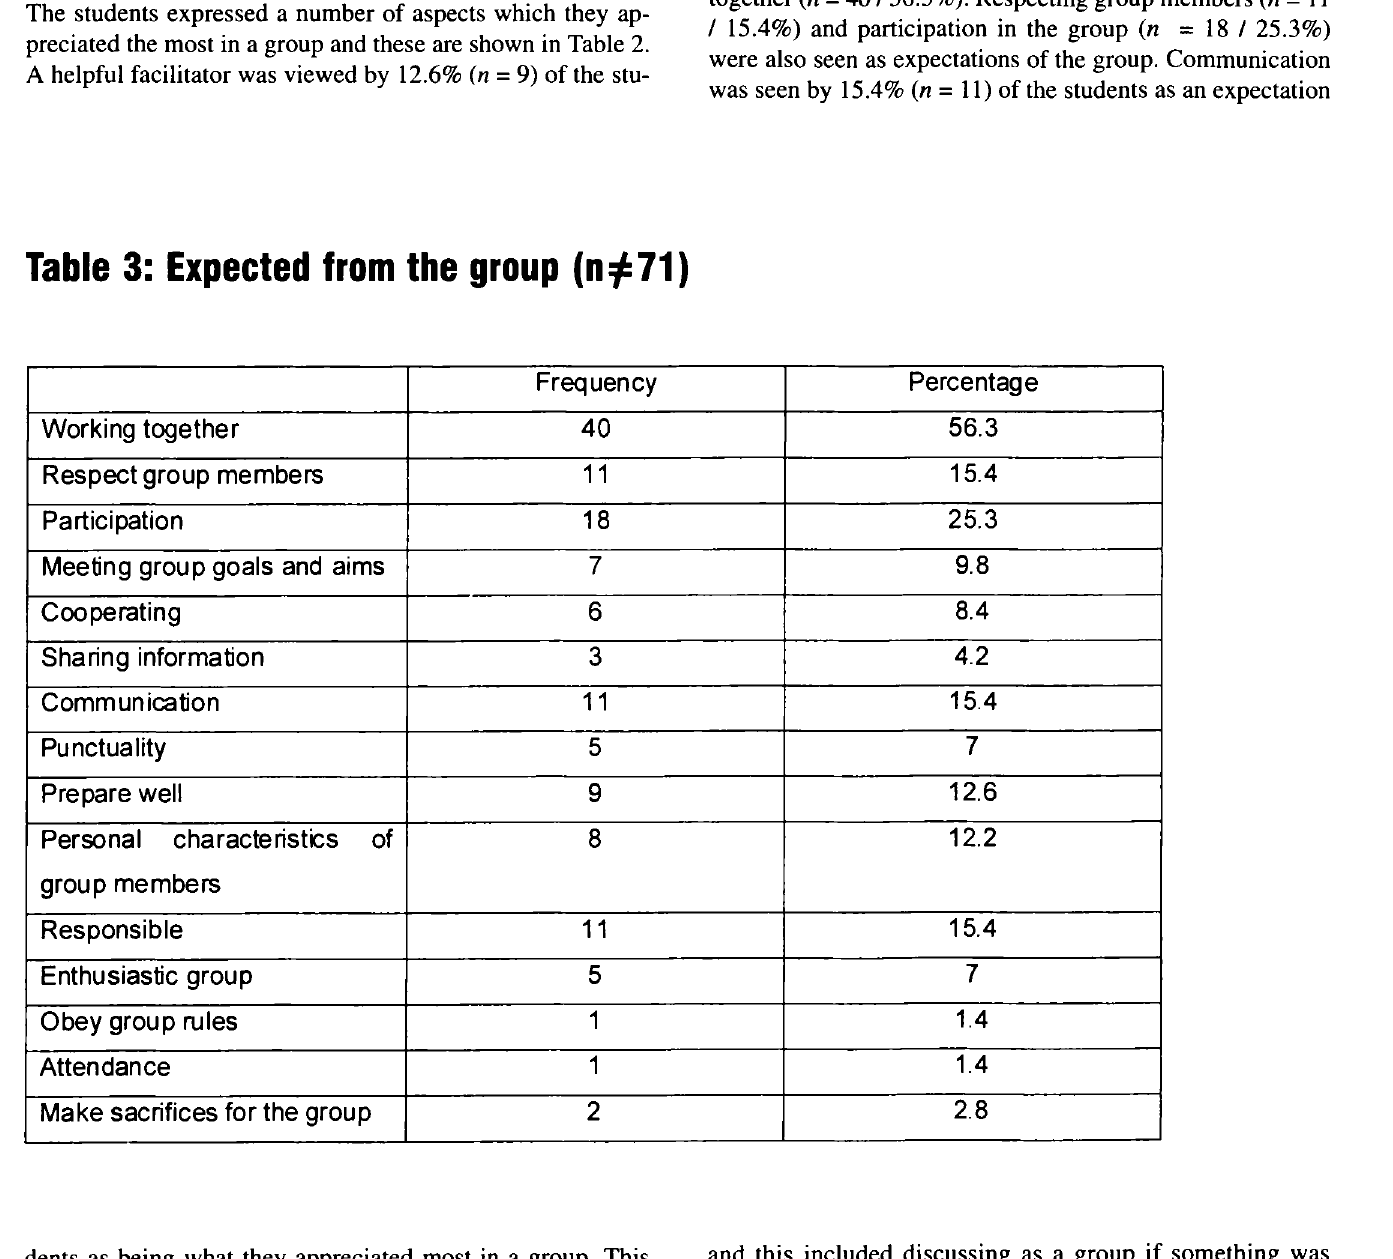
Frequency Percentage